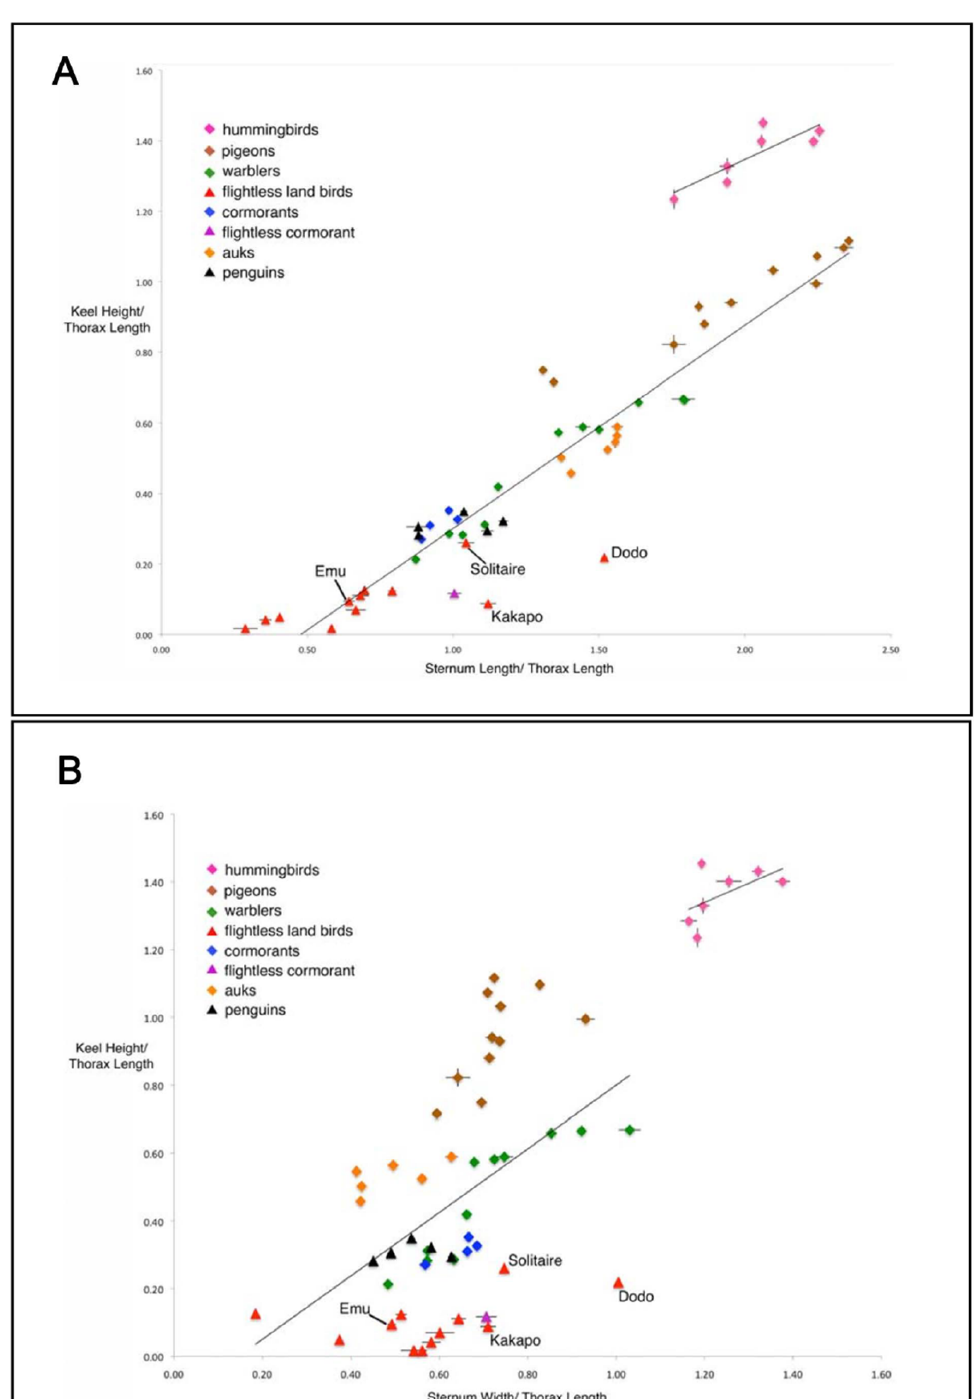
Figure 3. ( A ) : Sternum length and keel height are correlated with mode of locomotion in birds. Scatterplot of measurements for sternum length and keel height, normalised for bird size by dividing by thorax length, for a range of bird groups. Each point on the graph represents one species. When possible multiple specimens were measured per species. Error bars show standard error between multiple specimen measurements. Flying species are represented as diamonds, flightless species as triangles. ( B ) : Sternum width and keel height are correlated with mode of locomotion in birds. Scatterplot showing measurements for sternum width and keel height, normalised for bird size by diving by thorax length, for a range of bird groups. Each point on the graph represents one species. Where possible multiple specimens were measured per species. Error bars show standard error between multiple specimen measurements. Flying species are represented as diamonds, aerially flightless species as triangles. Figure adapted from [8].